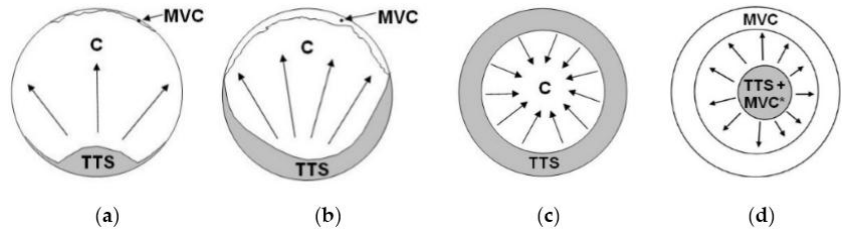
Figure 7. Schemes of the different models of micro-fracture map (MFM) in bluntly-notched samples of pearlitic steel under hydrogen embrittlement (HE) environmental conditions: ( a ) model I; ( b ) model II; ( c ) model III; ( d ) model IV.